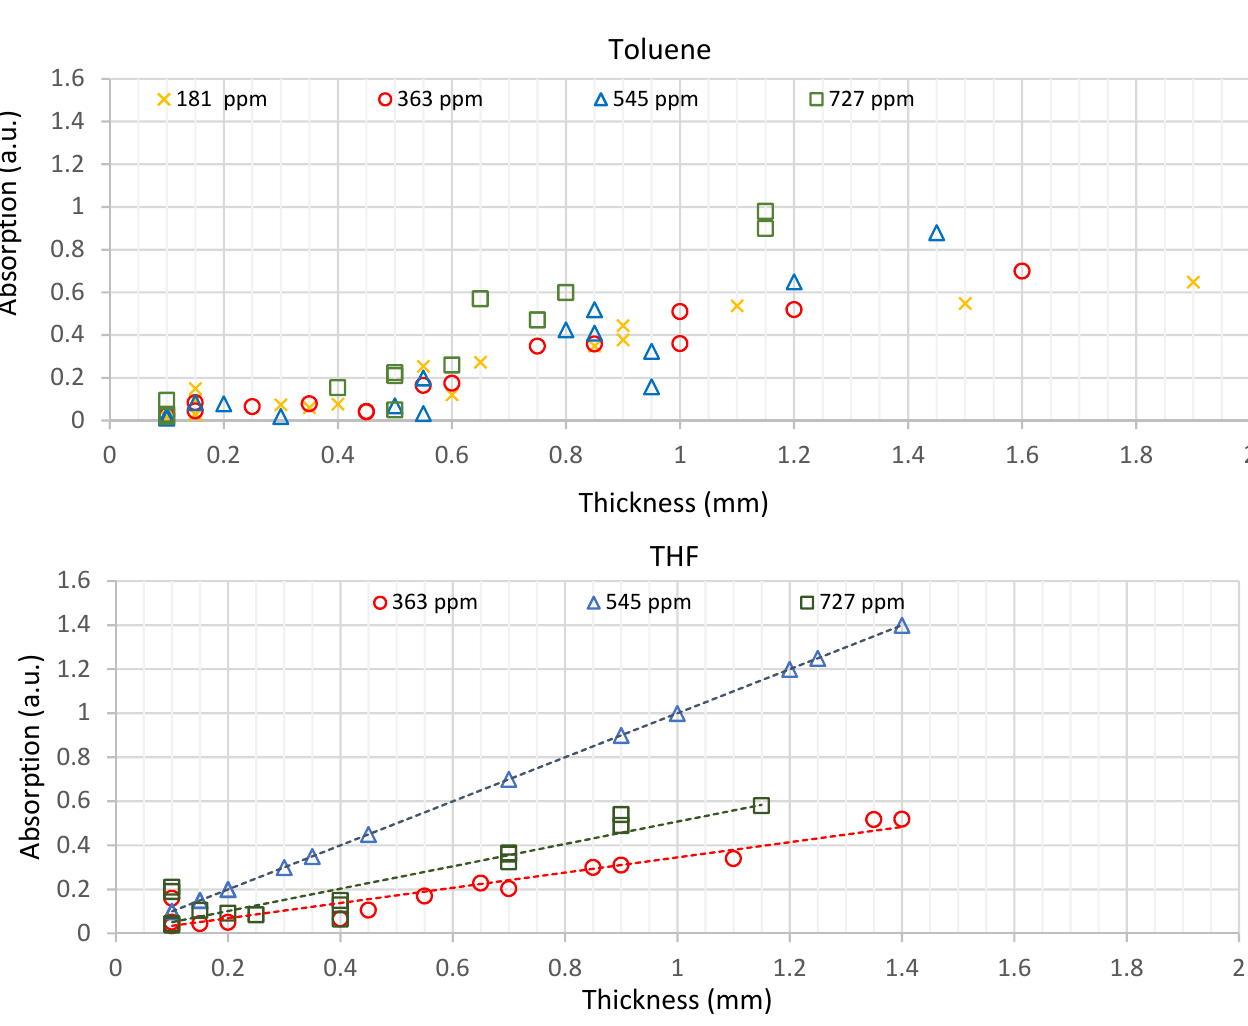
Figure 8. Relationship between absorption and thickness, for membranes manufactured using the solvent toluene and THF, with indicator concentrations of from 181 ppm to 727 ppm.